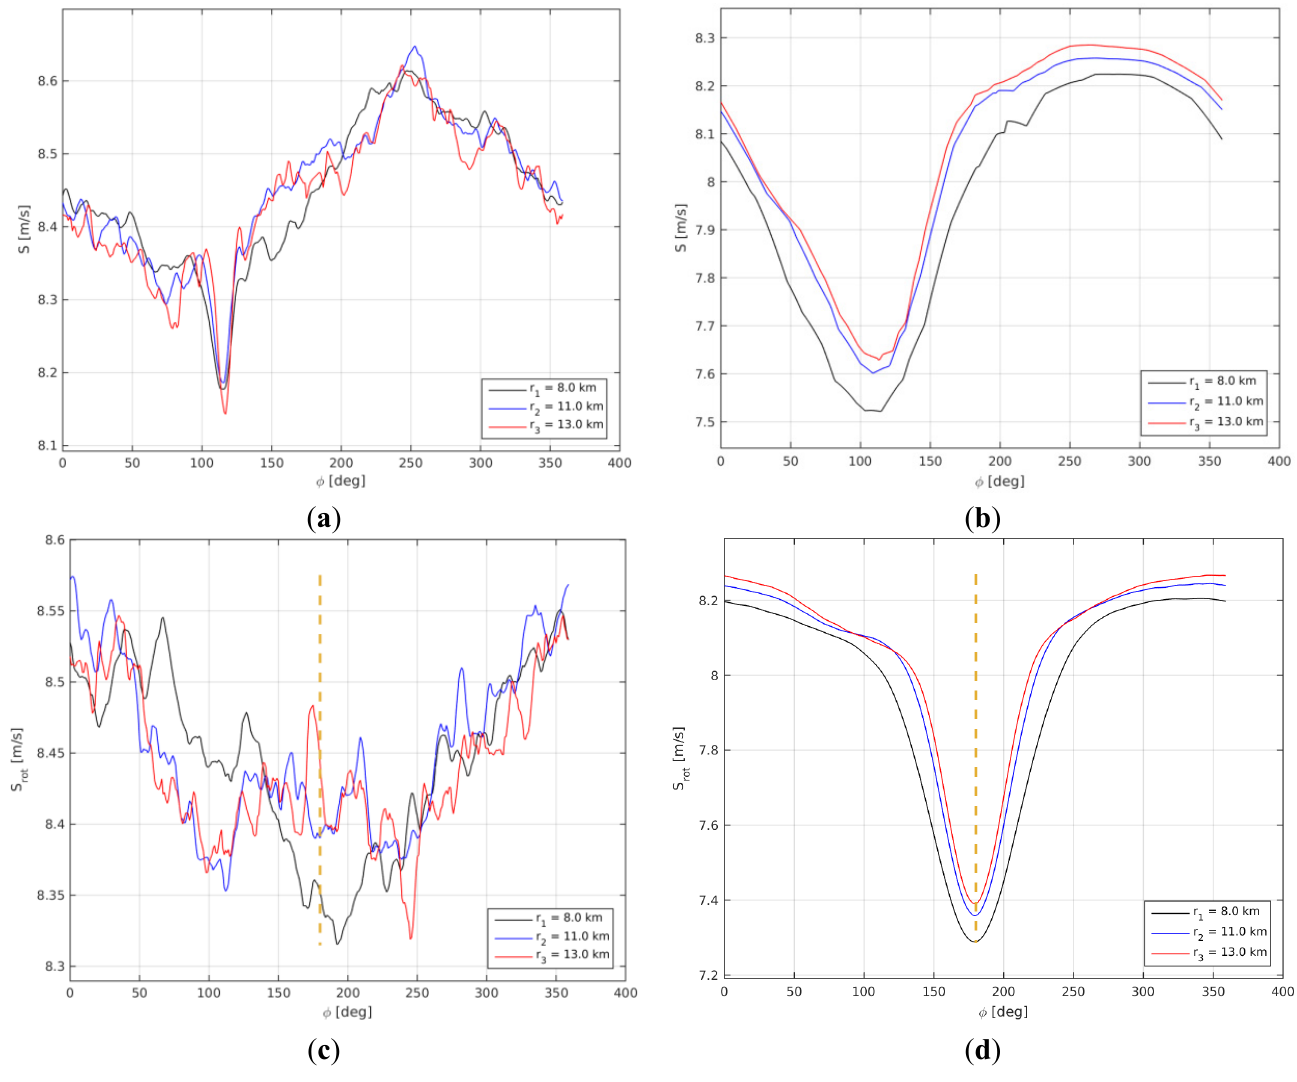
Figure 12. Results for Horns Rev 2. ( a ) wind speed summations without rotation (mean wind speed gradient) ( S ) based on SAR; ( b ) WRF; ( c ) wind speed summations with rotation ( S rot ) based on SAR; ( d )